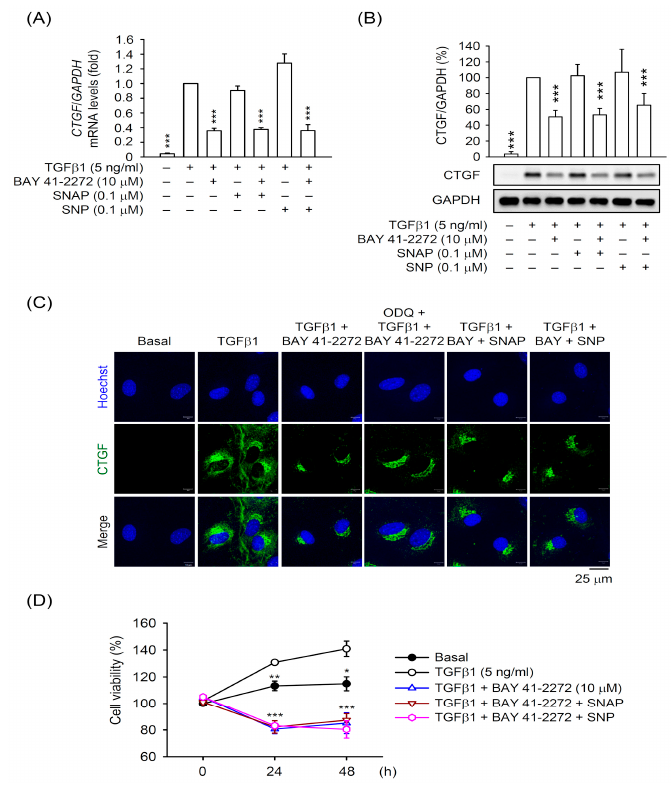
Figure 4. NO donors did not affect the inhibition of TGF β 1-activated HSCs by BAY 41-2272. HSCs were preincubated with BAY 41-2272 (10 μ M) in the presence or absence of SNAP (0.1 μ M) or SNP (0.1 μ M) for 30 min before activation by TGF β 1 (5 ng/mL) for another ( A – C ) 6 h or ( D ) 24–48 h. ( A ) mRNA levels of CTGF and GAPDH were determined by quantitative RT-PCR. ( B , C ) Expressed CTGF and GAPDH proteins were measured by ( B ) Western blot and ( C ) immunofluorescent staining using the corresponding antibodies. ( D ) Cell viability was measured using the WST-1 assay and monitored spectrophotometrically at 450 nm. All data are expressed as mean ± SD ( n = 3). * p < 0.05, ** p < 0.01, *** p < 0.001 compared with the TGF β 1 alone.